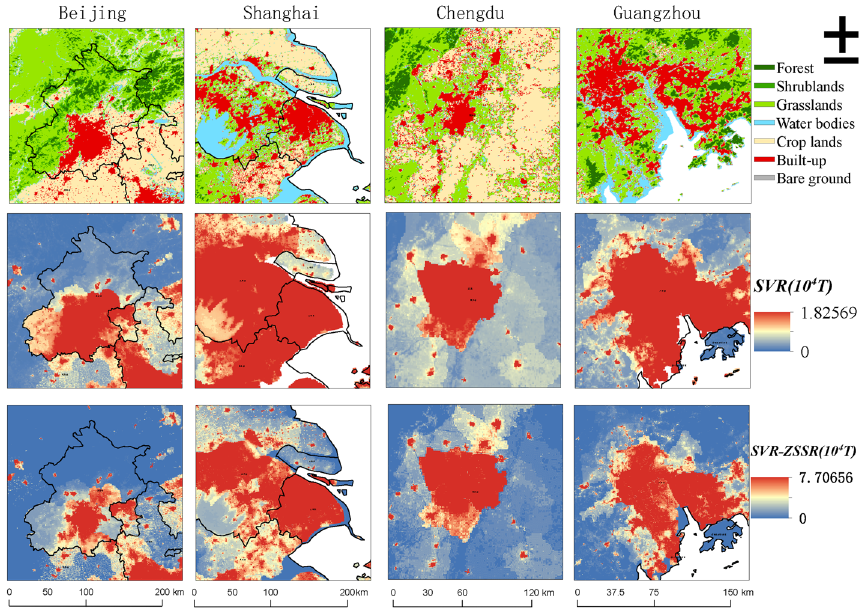
Figure 3. Comparison of SVR model and SVR-ZSSR model results. The figs were generated using the ArcGIS Desktop (ESRI, Inc, Version 10.7, https:// deskt op. arcgis. com/ zh- cn/).